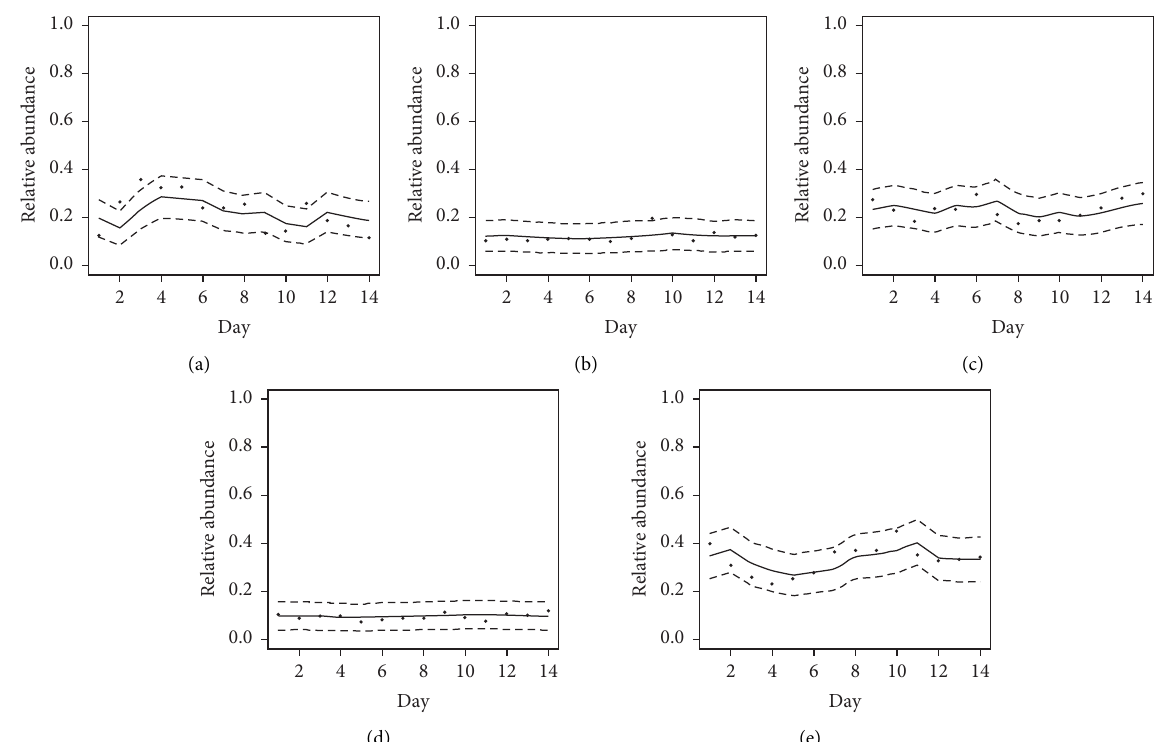
Figure 2: Model fitting each family in the healthy male. Relative abundances reported are represented by solid points. The solid line shows the estimated values. Standard deviation interval has also been plotted with dashed lines, E ( y it ) ± 2 · (b) Porphyromonadaceae. (c) Rikenellaceae. (d) Ruminococcaceae. (e)